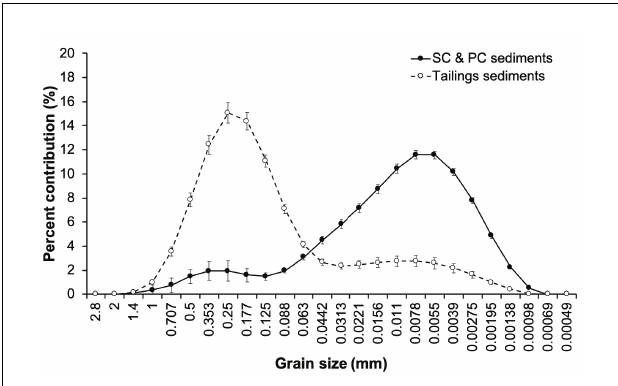
FIGURE 11 | Mean particle size distribution ± 95% confidence intervals of the tailings ( n = 15) and control (SC and PC) sediments ( n = 6) at 365